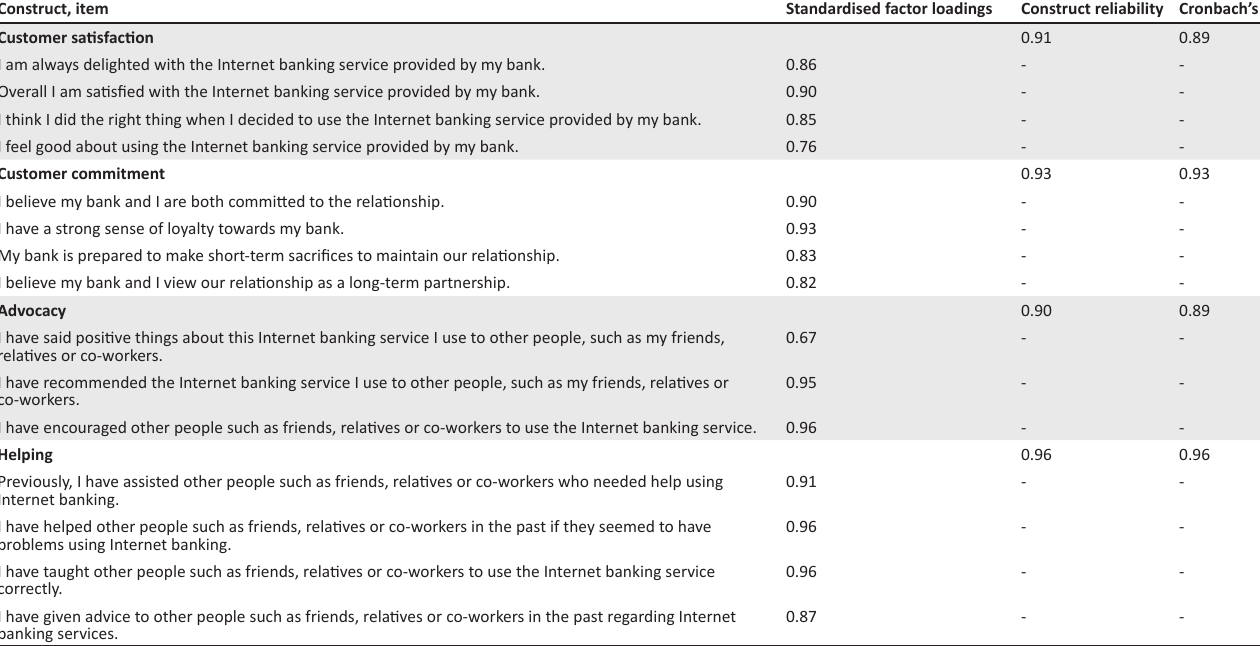
TABLE 2: Measurement model: standardised factor loadings, construct reliability and Cronbach’s alpha values. Construct,